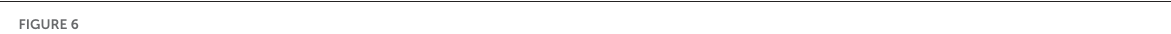
FIGURE6 in the annual ring wood. (F) The allelic effects of SNP MA_15508_8004 on the three traits of the annual ring wood. SNPs depicted in (C,F) are eclipsed in the corresponding Manhattan plot, and the error bar represents ± standard deviation for phenotypic values. Different letters represent a significant difference ( P < 0.05) between the mean values of different genotypes. Phenotypic values are scaled by their mean value. The dashed lines linking (A,B) , and linking (D,E) are drawn to identify if MV-GEMMA or BLINK increases the power in the same contig as